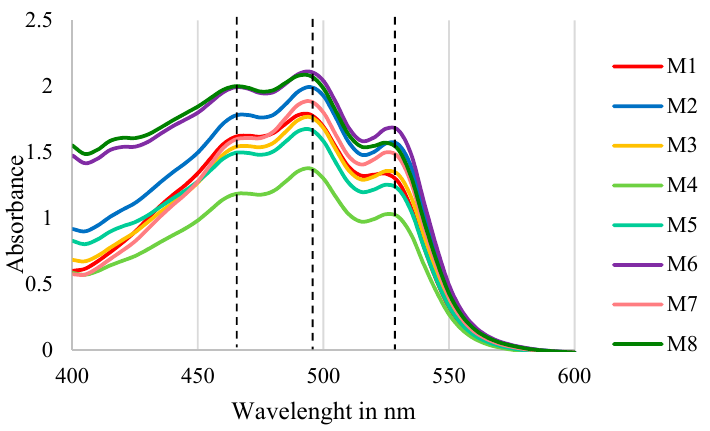
Figure 7. Spectrophotometric scans of the pigment extracts from all isolated strains.